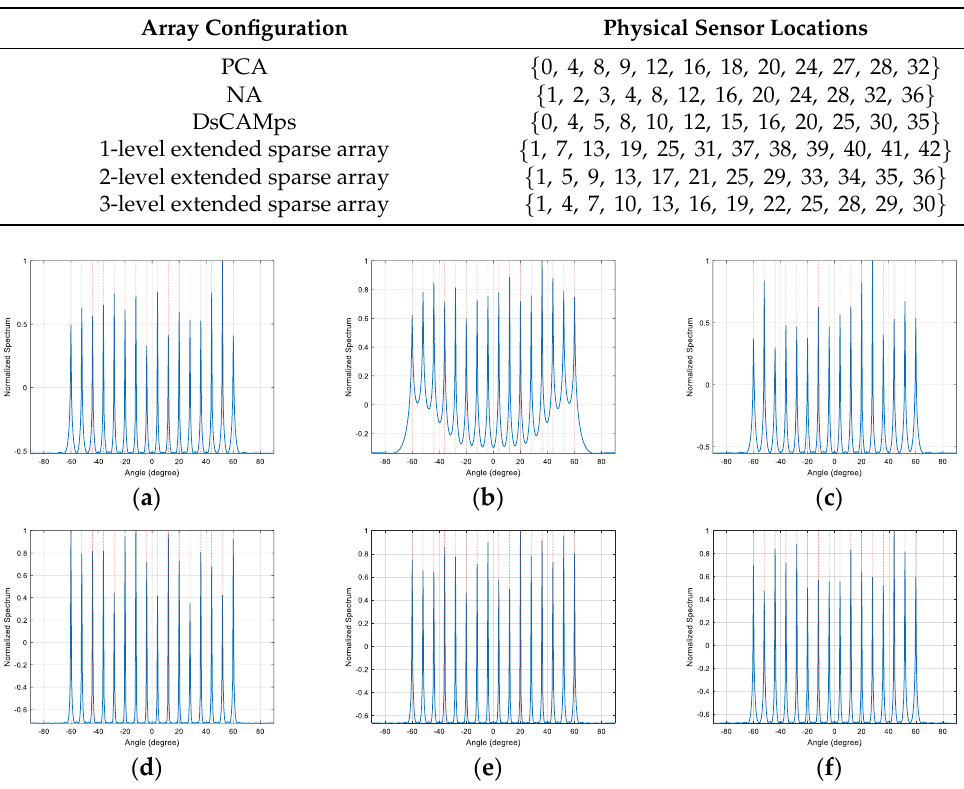
Figure 8 Figure 8. Comparisons of spatial spectra for ( a ) CPA, ( b ) NA, ( c ) DsCAMps, ( d ) 1-level extended sparse array, ( e ) 2-level extended sparse array, and ( f ) 3-level extended sparse